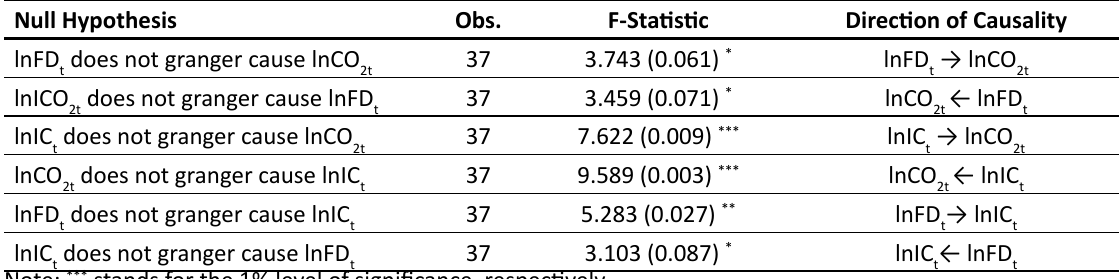
Table 9: Result of Granger Causality